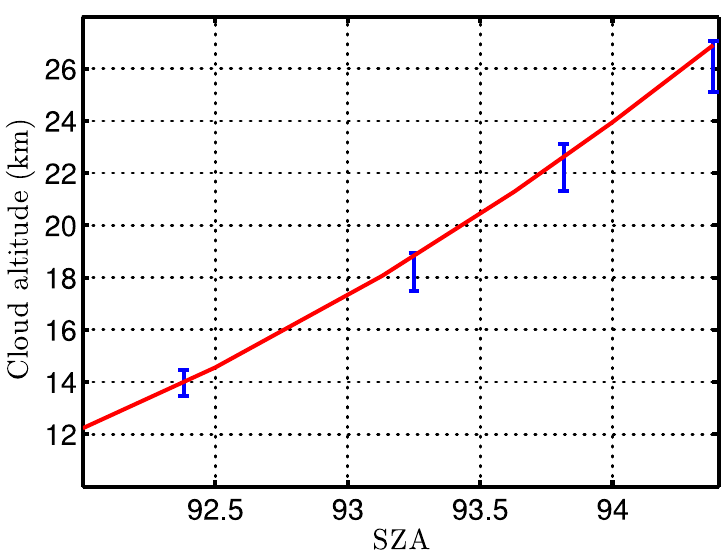
Figure 6. SZA max values obtained for different PSC altitudes under tropospheric cloud free conditions (red solid line) and when a tropospheric cloud layer with a total opacity of 1 is added at an altitude of 5 km (blue error bars). The errors were computed according to the model SZA resolution at the CI maximum.